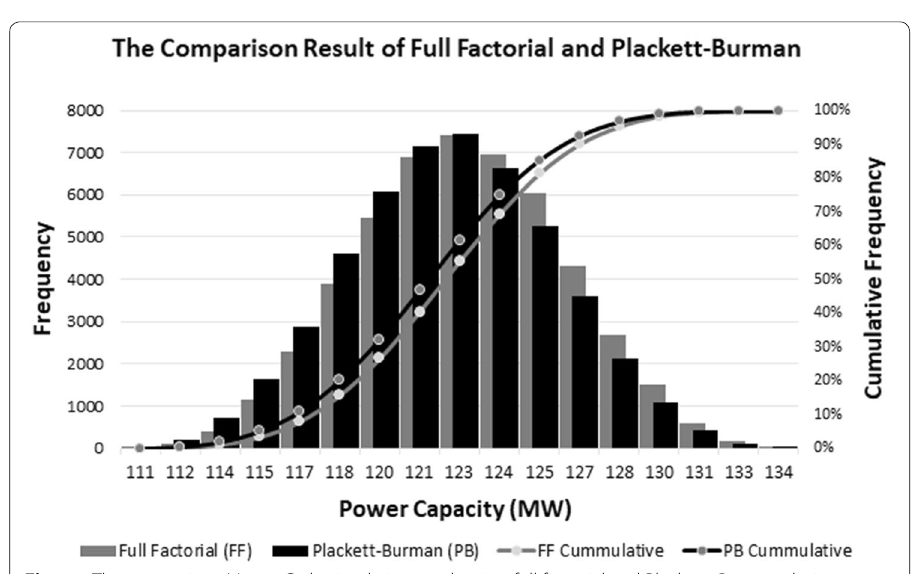
Fig. 14 The comparison Monte Carlo simulation result using full factorial and Plackett–Burman